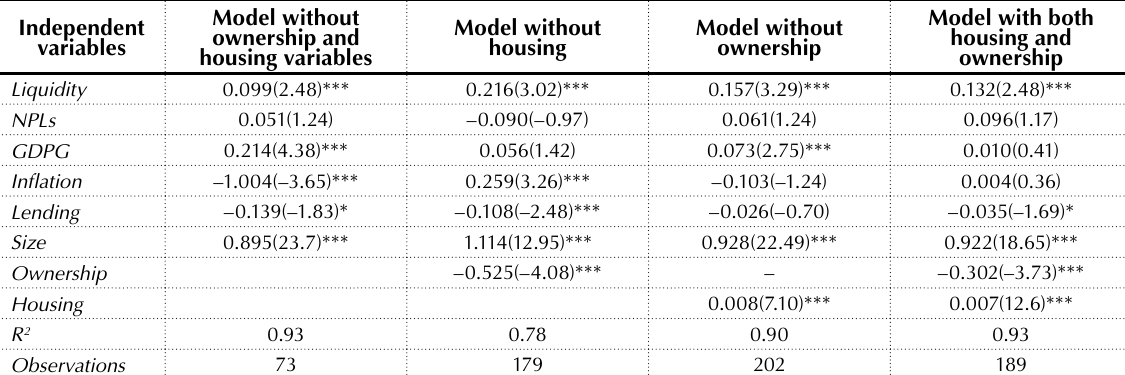
Table 3. The dependent variable is local loans of commercial banks Independent variables